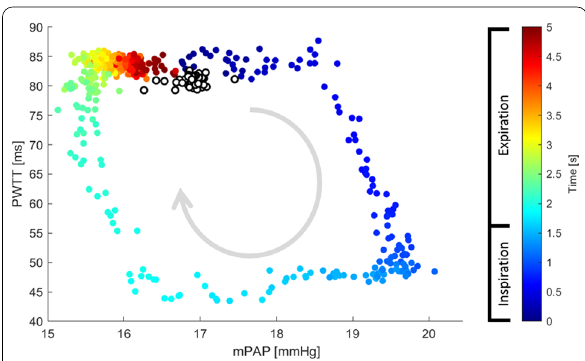
Figure 1: Relationship between PWTT and mPAP with colored dots representing the time of each heartbeat within the respiratory cycle (absolute time and phase of respiratory cycle on the right). Apnea (black open circles). Results: Ventilation-dependent changes in were seen in both vari- ables, PWTT and PAP. But interestingly, the changes in PWTT were not synchronous with the ones of the PAP. Thus, plotting PWTT as a function of PAP for each heartbeat revealed a characteristic hyster- esis (Figure 1, filled dots). Visualizing the respective timepoint of each heartbeat within the respiratory cycle by a color gradient from blue (inspiration) to red (expiration) allowed identifying the dependency of PWTT on both, PAP and the timepoint within the respiratory cycle: at the beginning of inspiration, mPAP rised while PWTT initially remained constant, but then started to decrease rapidly when mPAP was about to reach its plateau. The same time course could be observed during expiration: mPAP decreased to a minimum, which was followed by an increase in PWTT. During apnea this hysteresis disappeared (black open